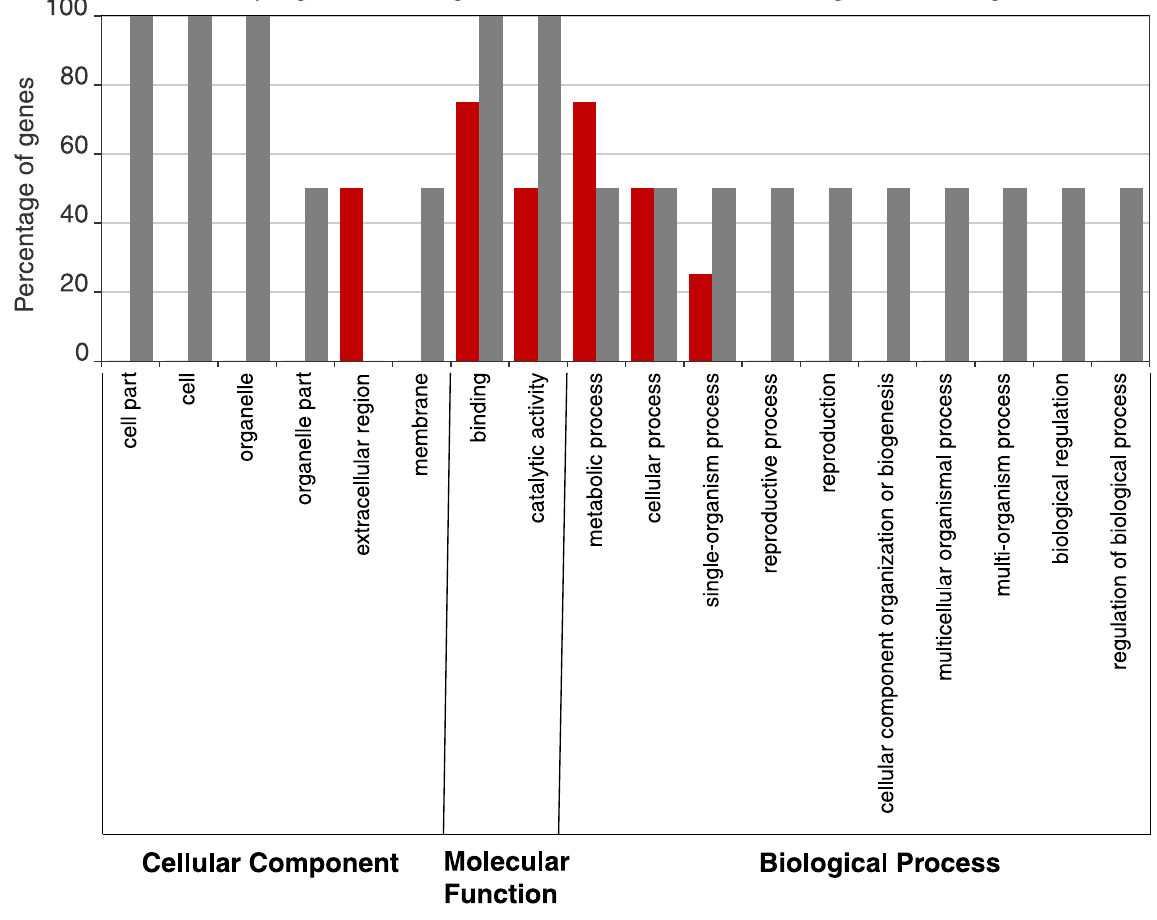
Fig 3. GO functional classification of cold induced DETs. The DETs were placed into three main GO categories: cellular component, molecular function, biological process.